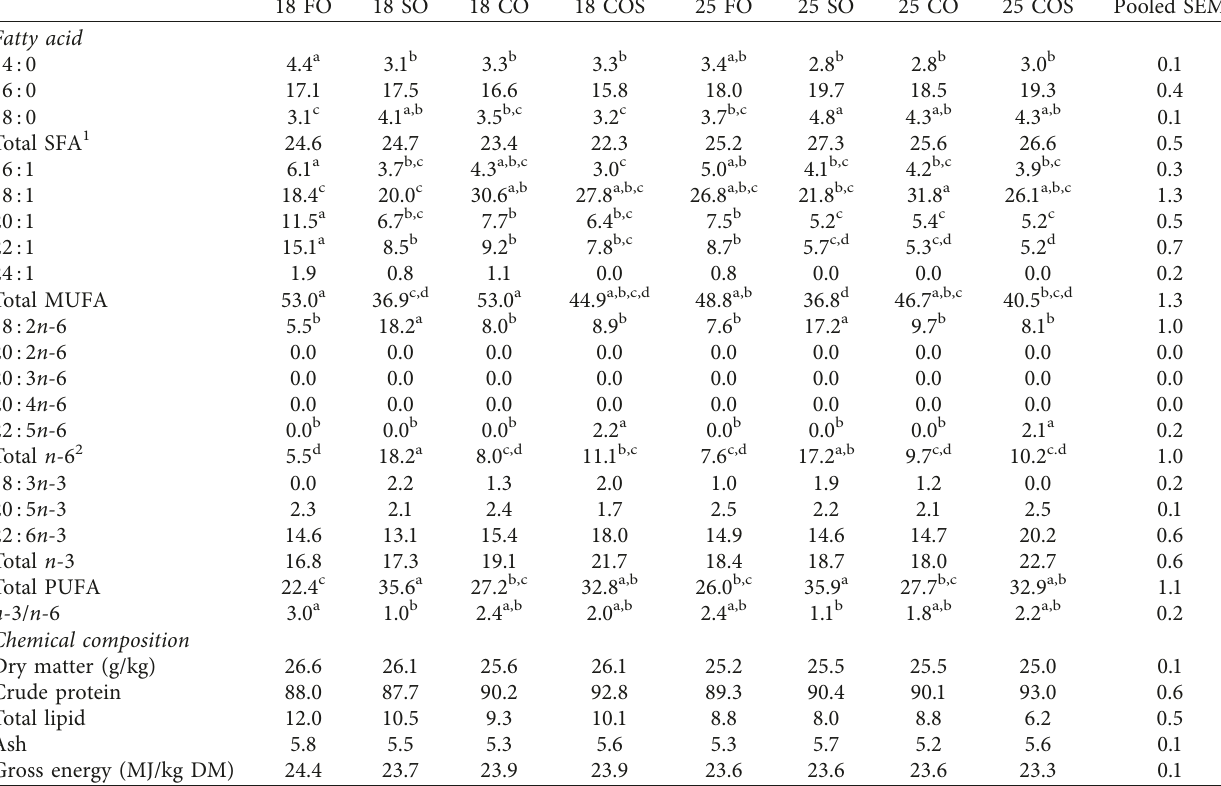
Table 5: Effects of feeding with a washout diet of herring oil on fillet composition (g/kg DM) and fatty acid profile (% of total fatty acids). 18 FO 18